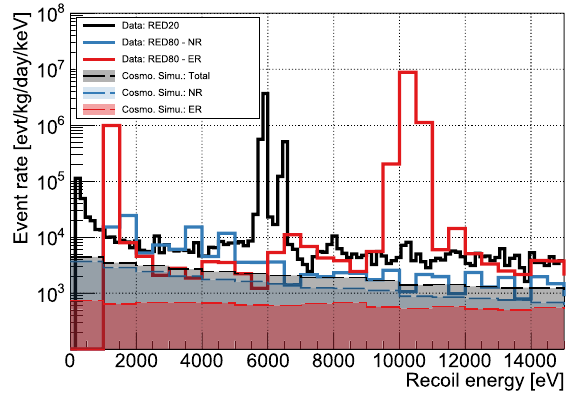
Fig. 7 Left: comparison of the simulated (blue) and the observed (red) 3 He proportional counter data while operated at the IP2I surface lab after 18 days of data taking. The red histogram has been obtained by subtracting the observed spectra from the LSM to subtract the internal alpha background of the detector. The simulation considers the IP2I building geometry discussed in the text with its averaged overburden of 3 m.w.e. as estimated from our muon flux attenuation measurements. As discussed in Sect. 3, due to the internal proportional counter back- ground, a statistically significant neutron contribution can be inferred from an observed rate larger than about 0.25 evt/day/bin at 95% C.L. Right: comparison between the observed data with the RED20 [32] and